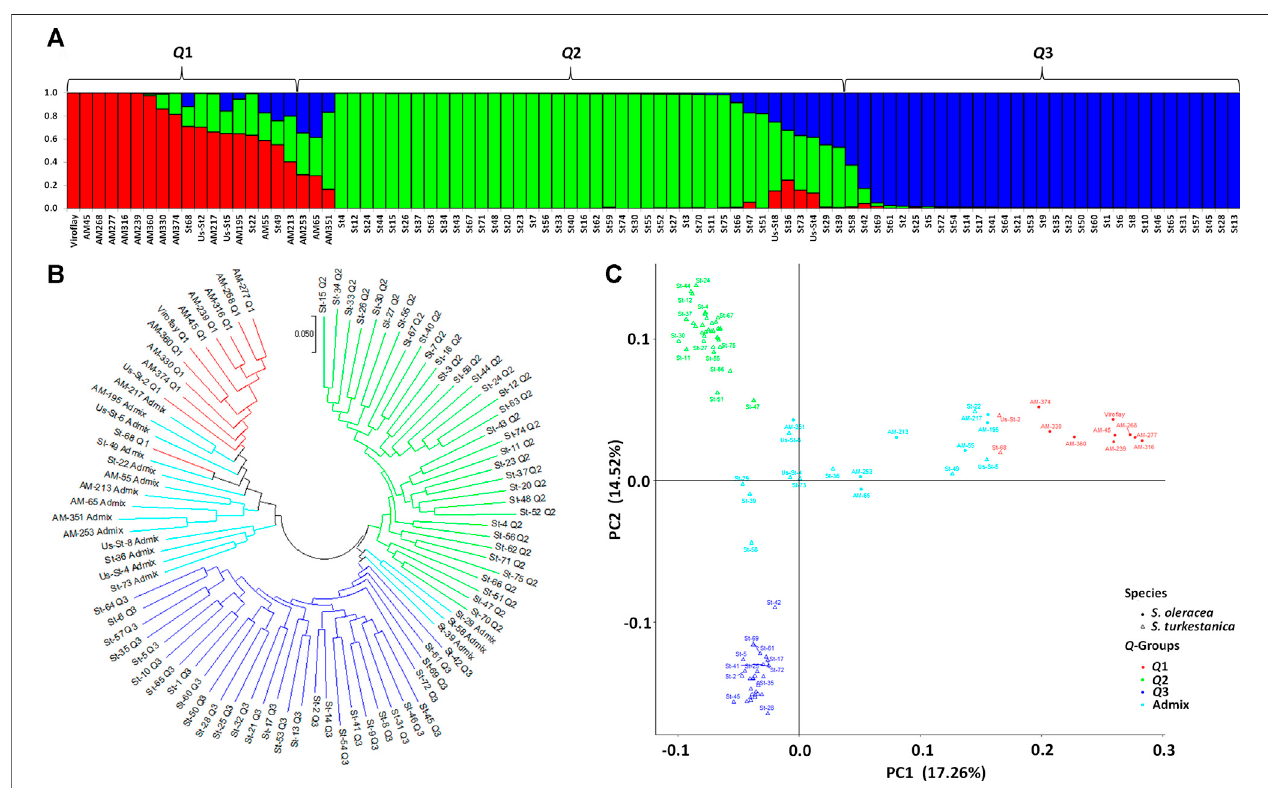
FIGURE 3 | Population structure of 92 accessions of two Spinacia spp. based on single nucleotide polymorphisms (SNPs). (A) Population structure of 16 S. oleracea and 76 S. turkestanica accessions based on 7,065 SNPs common to these accessions, with K (cid:1) 3 groups, Q 1 ( S. oleracea and S. turkestanica ), Q 2 ( S. turkestanica ), and Q 3 ( S. turkestanica ), determined using STRUCTURE. (B) Neighbor joining tree of the 16 S. oleracea and 76 S. turkestanica accessions. (C) Principal component analysis (PCA) of the 16 S. oleracea and 76 S. turkestanica accessions based on the